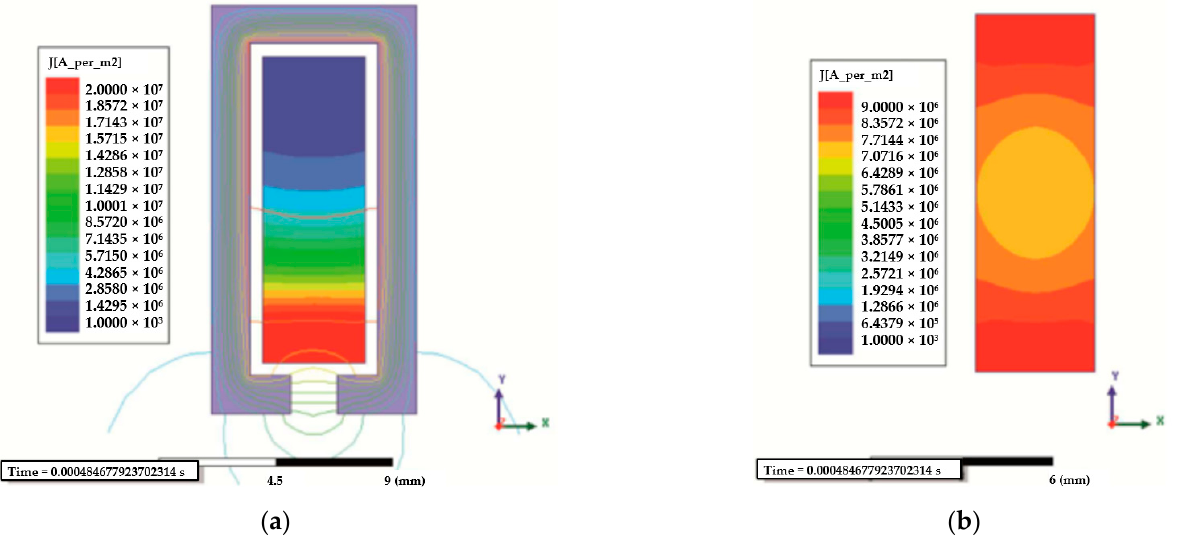
Figure 6. Current distribution in a bar excited with a sine current f = 530 Hz. ( a ) bar surrounded by a magnetic circuit ( b ) bar in air.